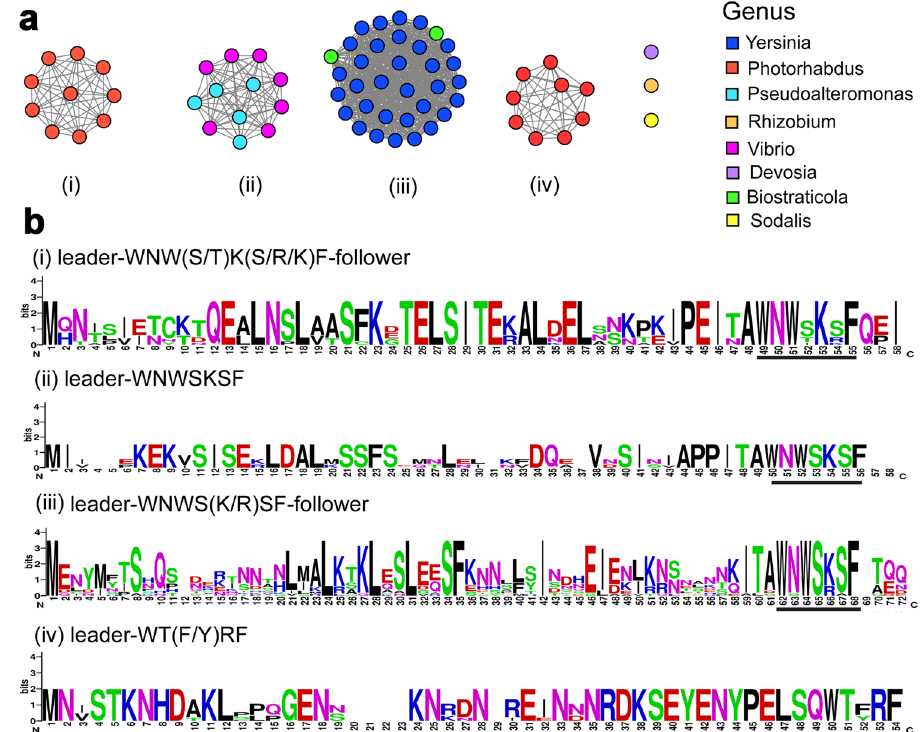
Fig. 5 Diversity and classi fi cation of darobactin-like BGCs. a The sequence similarity network of DarE enzymes. Each node in the network represents a putative DarE sequence, and each edge represents sequences with BLASTP E values below 1E-165. b The conserved core sequences in the putative precursor peptides are shown by black